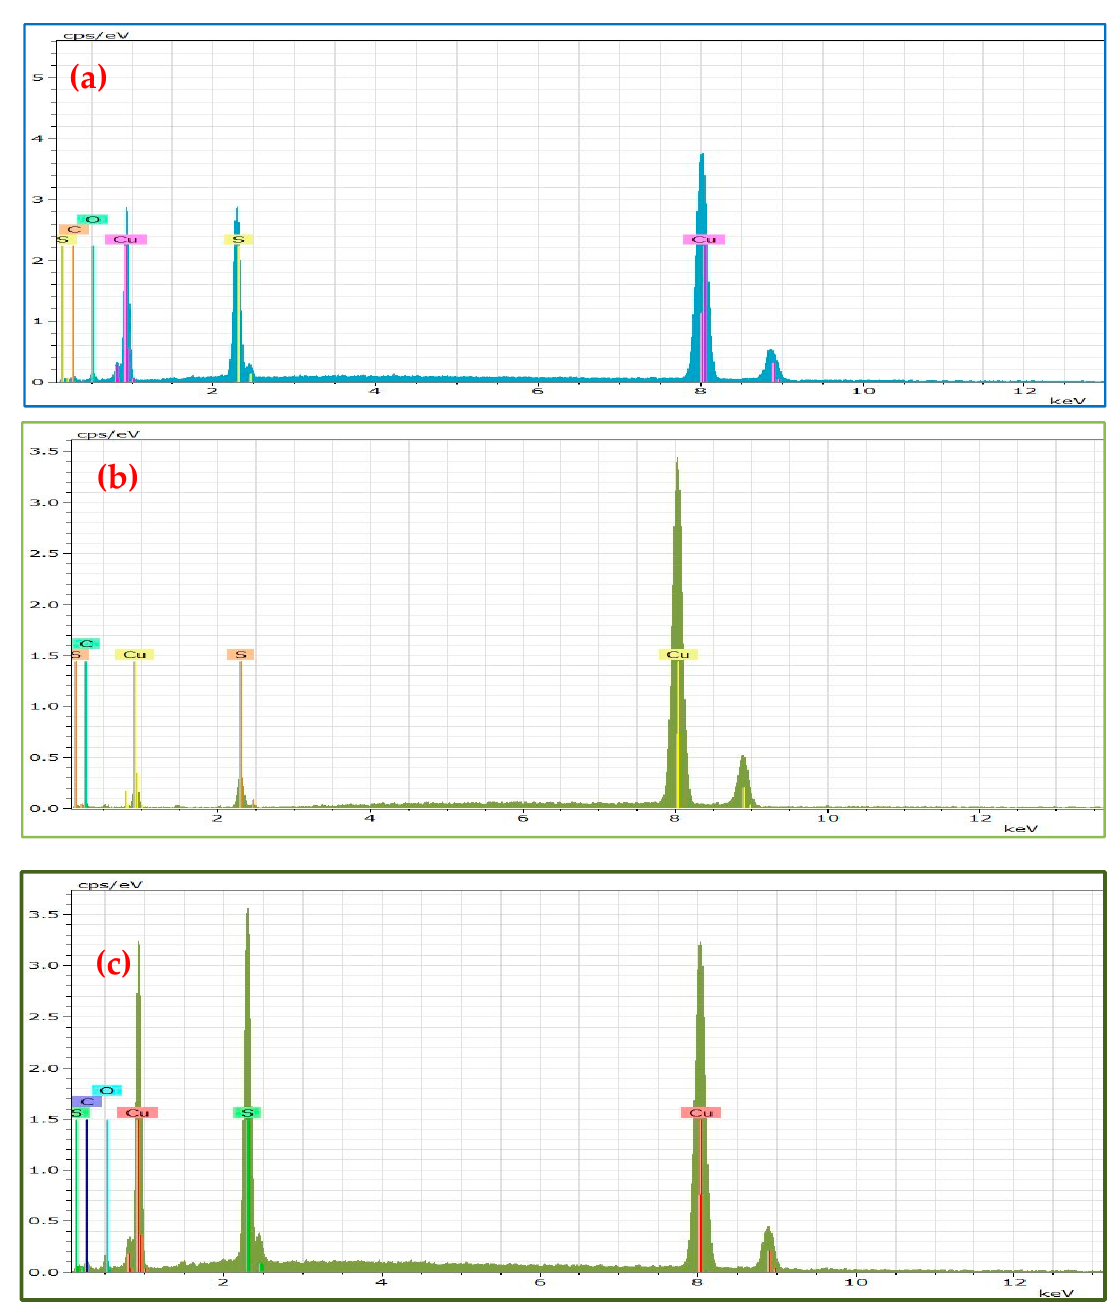
Figure 4. EDX spectra of Cu x S y nanoparticles prepared in ( a ) OLA, ( b ) HDA, and ( c ) DDA at 190 °C using complex 1. Table 1. EDX analysis of OLA@Cu 9 S 5 , HDA@Cu 9 S 5 , and DDA@Cu 9 S 5 NPs obtained at 190 °C using complex 1 and complex 2.